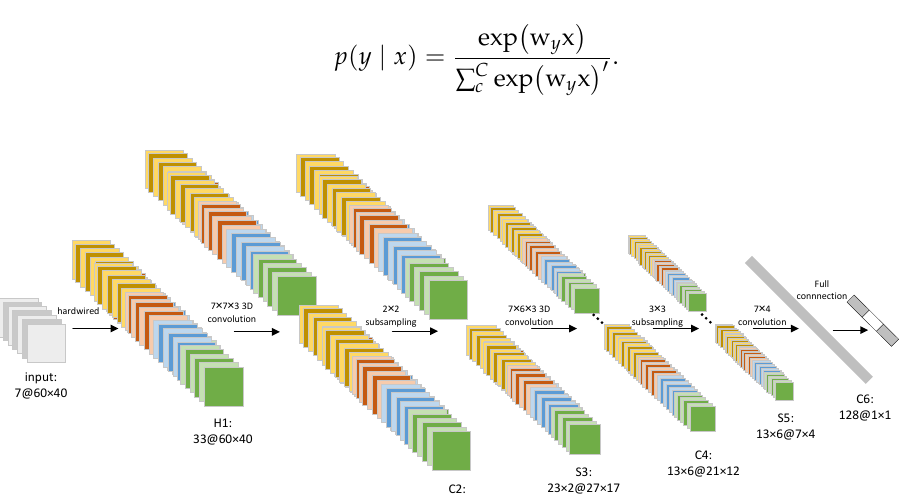
Figure 3. C3D convolutional neural network structure. This architecture consists of 1 hardwired layer, 3 convolution layers, 2 subsampling layers, and 1 full connection layer. Among them, H is hardwired layer, C is convolution layer, S is subsampling layer, 7@60 × 40 represents 7 continuous frames of 60 ×